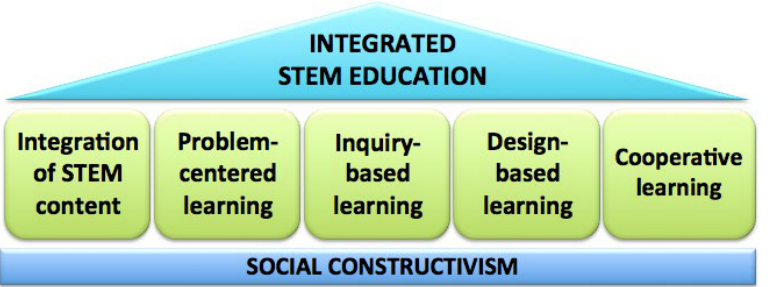
Figure 1. Theoretical framework for instructional practices in integrated